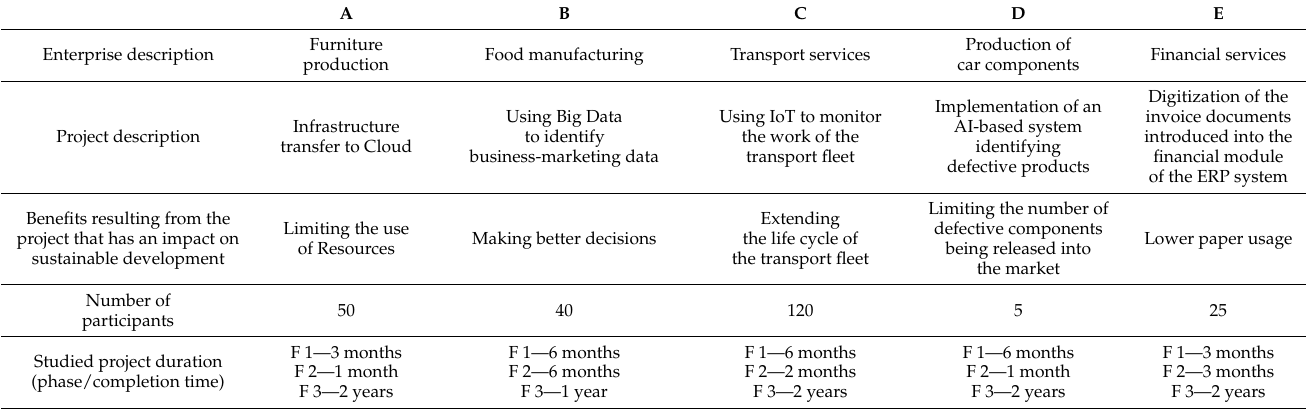
Table 2. Characteristic of the studied projects. Source: Own study. A B C